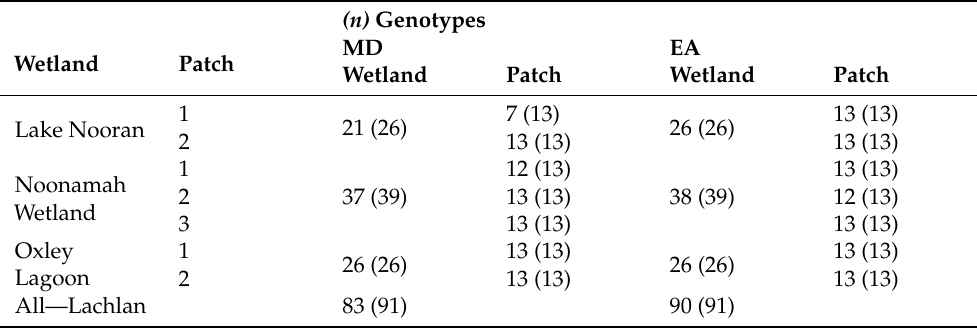
Table 2. Number of genotypes within each wetland and patch for Marsilea drummondii (MD) and Eleocharis acuta (EA). The numbers in brackets are the numbers of samples collected. (n) Genotypes MD EA Wetland Patch Wetland Patch Wetland